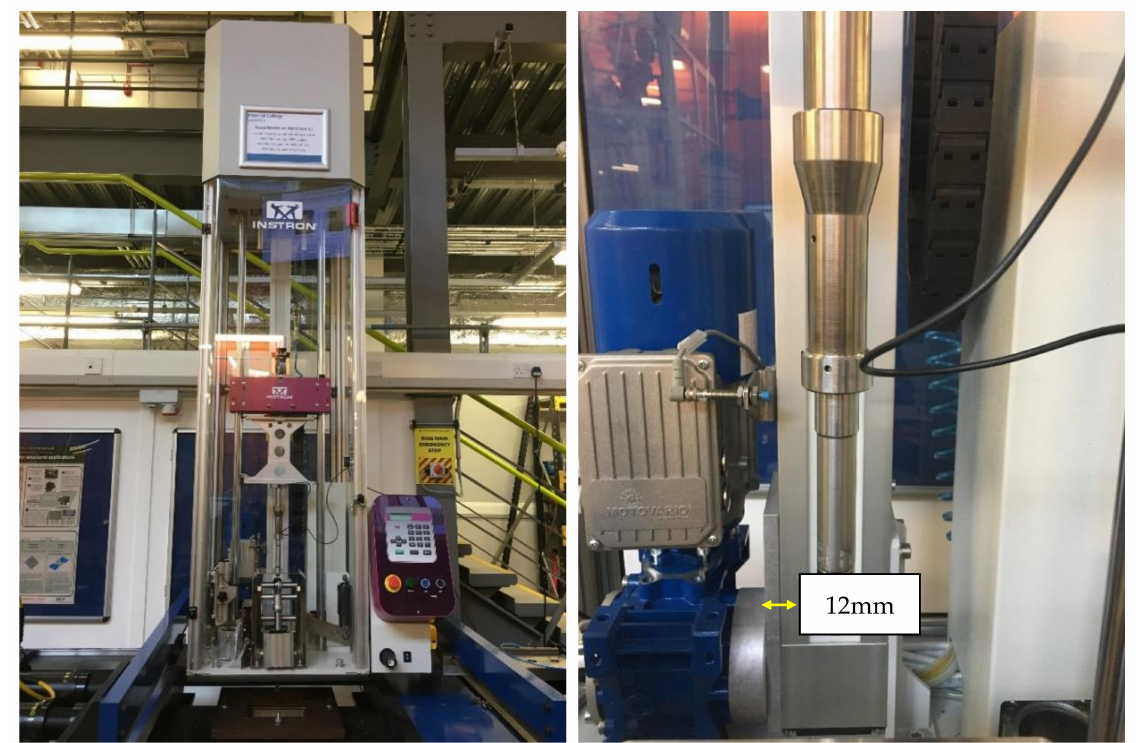
Figure 2. INSTRON ® drop tower ( left ) and close-up image of the impactor ( right